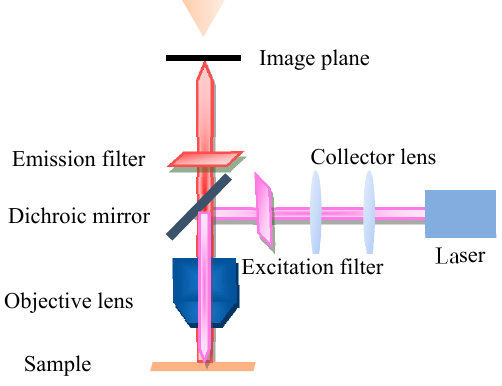
Figure 2. Principle scheme of fluorescence microscopy.